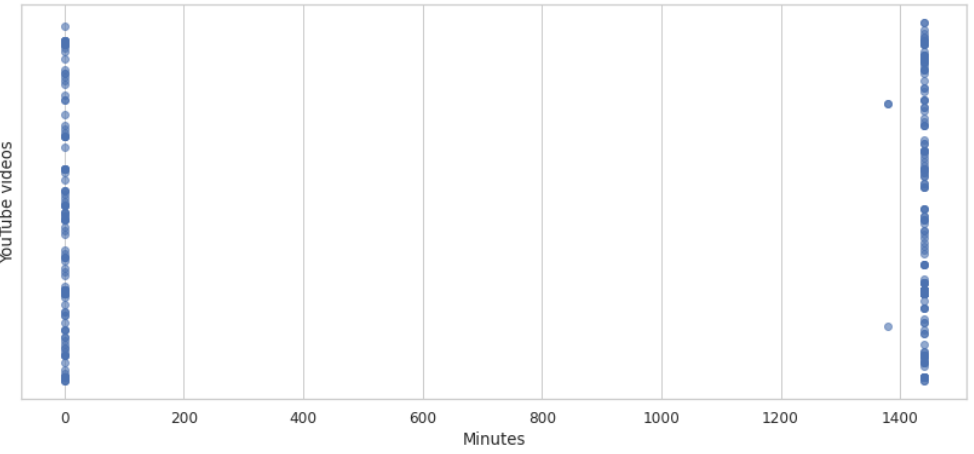
Figure 10. Temporal distribution of Odysee